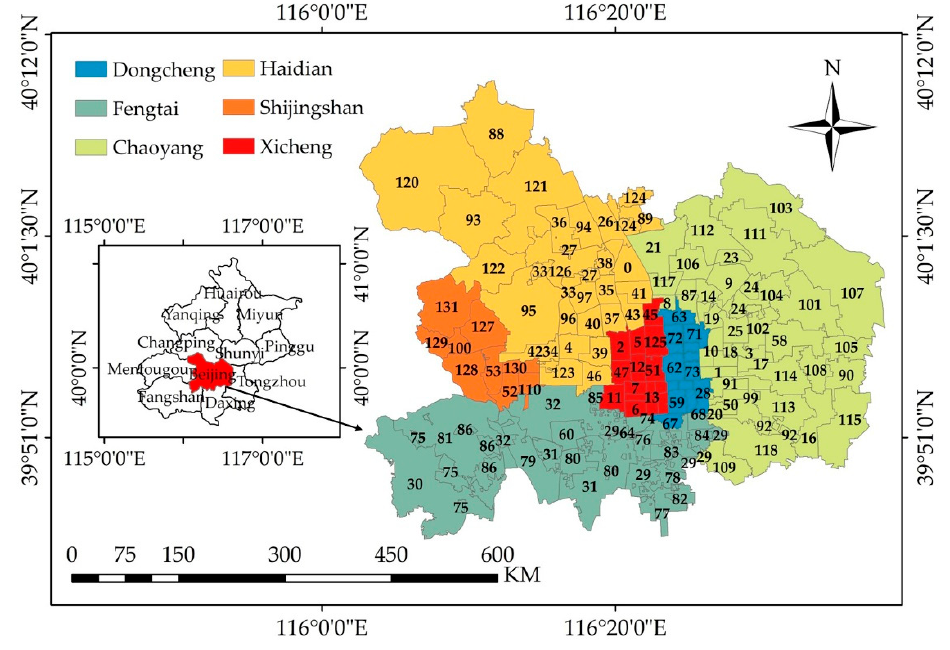
Figure 1. Study area in Beijing, China. (Details in Appendix A).